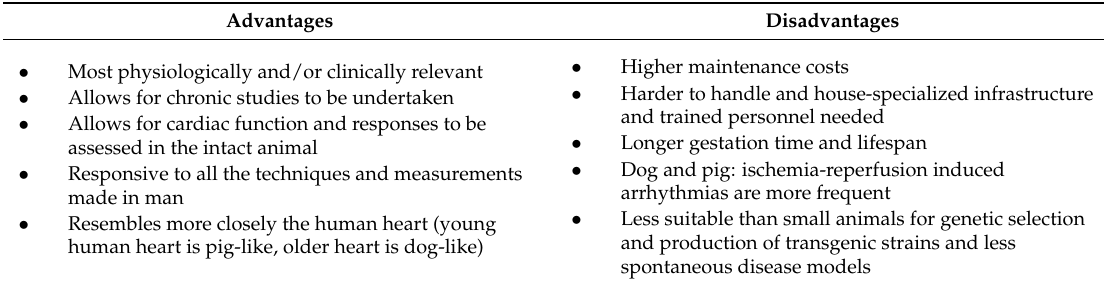
Table 1. Advantages and disadvantages of large animal models.